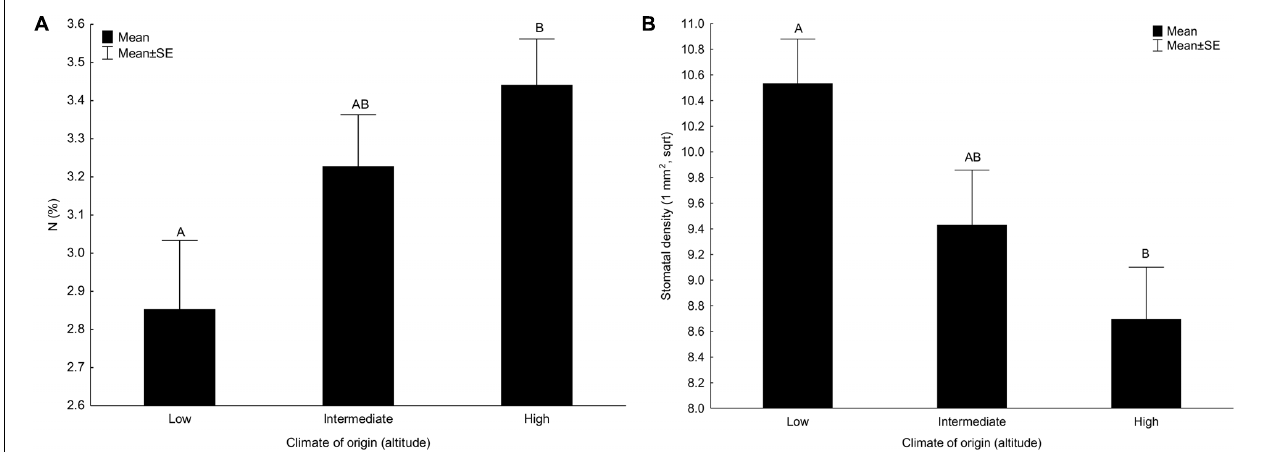
FIGURE 1 | Effect of climate of origin expressed as altitudinal category on (A) content of nitrogen (N) and (B) stomatal density. Columns sharing the same letter are not significantly different from each other ( p > 0.05).